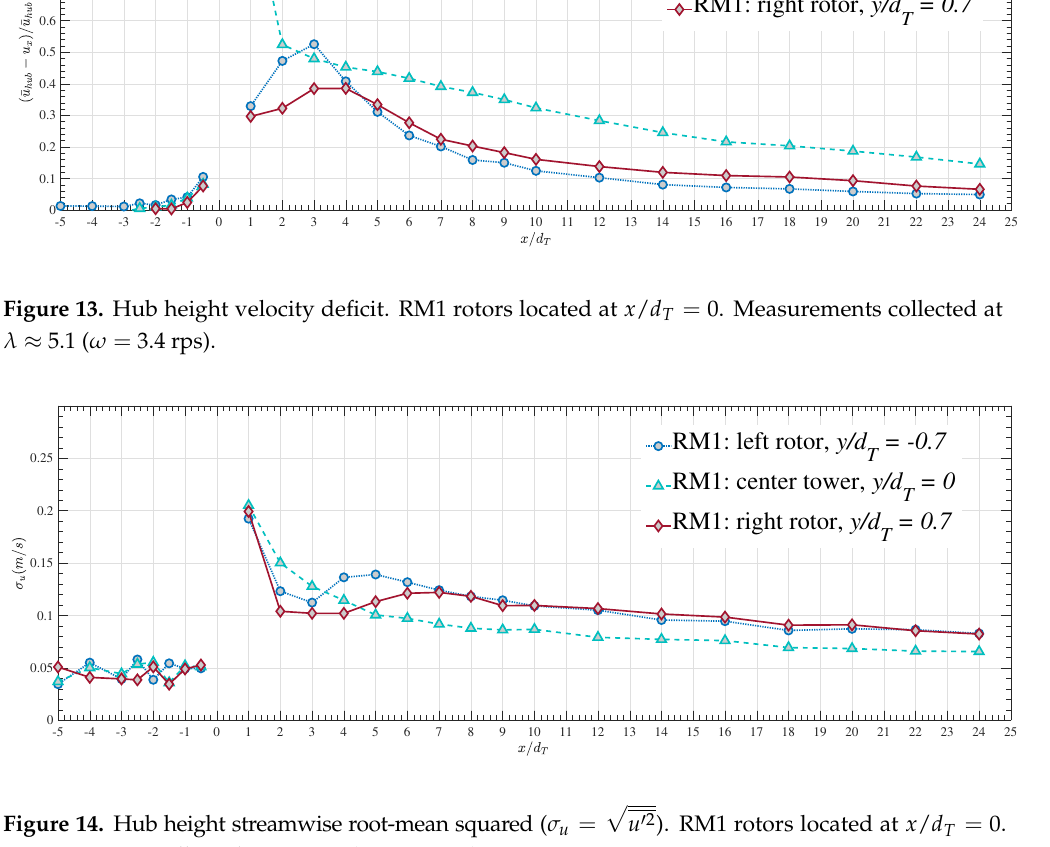
Figure 14. Hub height streamwise root-mean squared ( σ u = Measurements collected at λ ≈ 5.1 ( ω = 3.4 rps).